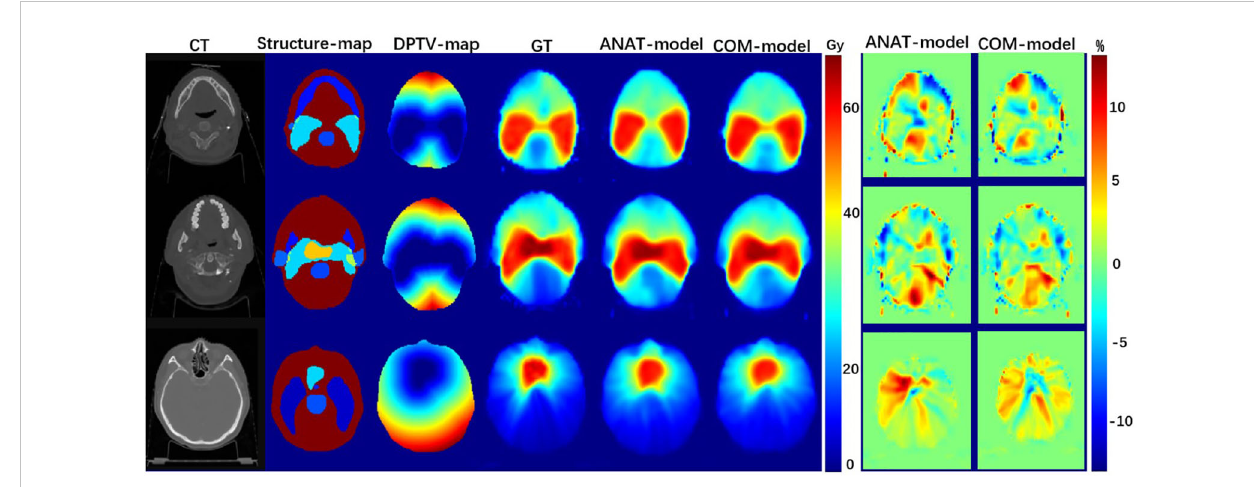
FIGURE 2 Examples of dose maps predicted by the COM model and ANAT model: the fi rst column, the CT maps as input; the second column, the structure- maps as input; the third column, the DPTV-maps as input; the fourth column, the dose maps of approved treatment plans; the fi fth column, the dose maps predicted by ANAT-model; the sixth column, the dose maps predicted by COM-model; the seventh column, the dose-difference maps for ANAT-model; the eighth column, the dose-difference maps for COM-model.